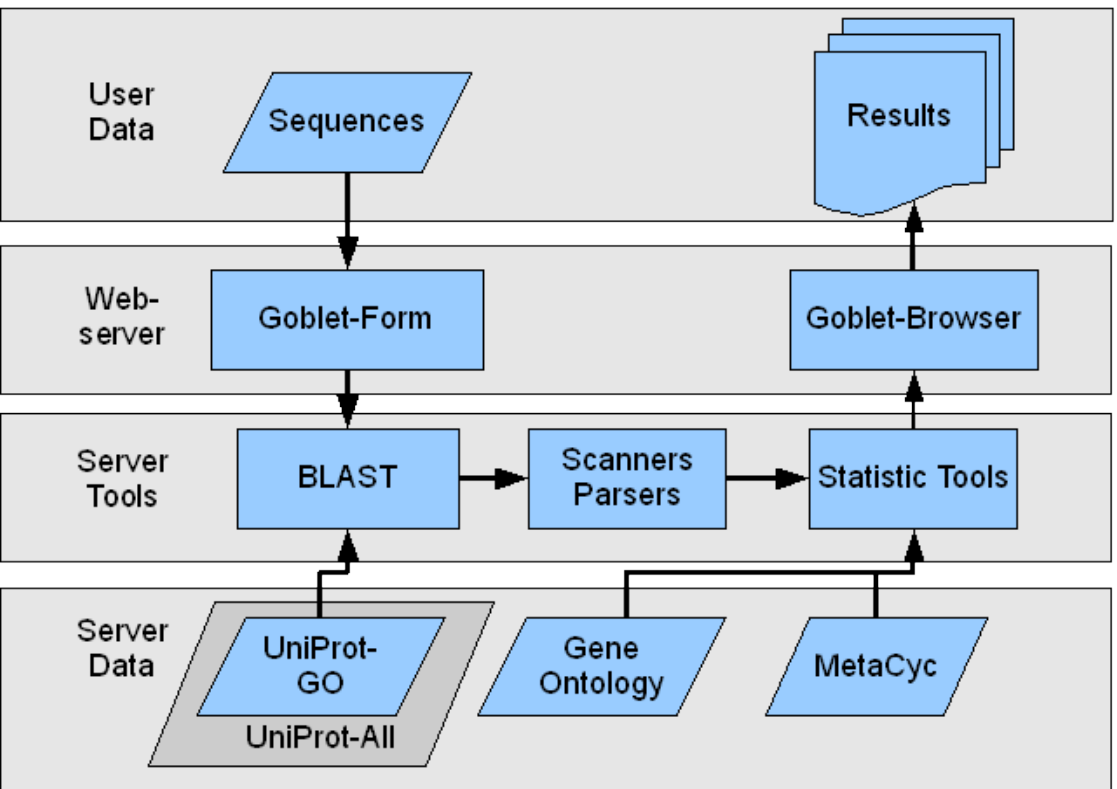
Figure 1: GOblet application